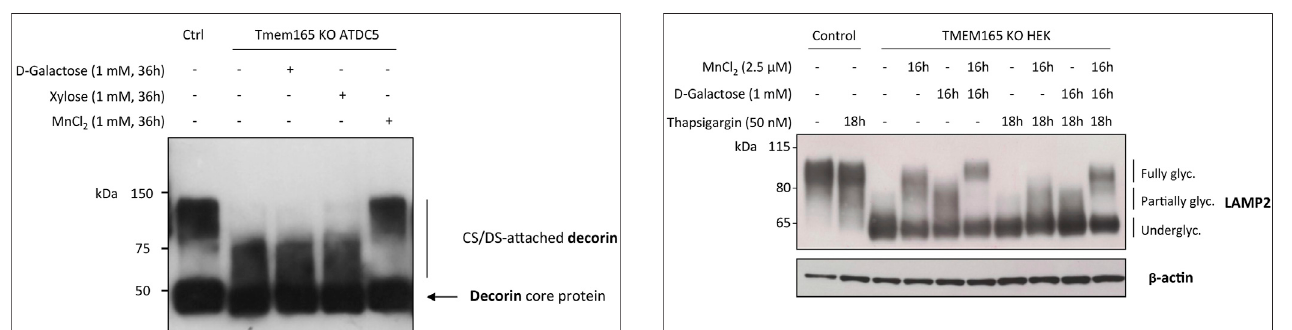
FIGURE 6 | Impact of thapsigargin on LAMP2 and TGN46 glycosylation pro fi les in HEK cells treated with MnCl 2 and/or D-Galactose. Western-blot of LAMP2 incontroland TMEM165KOHEKcells, treatedfortheindicatedtimes with or without 2.5 μ M MnCl 2 and/or 1 mM D-Gal, in the presence or absence of 50 nM thapsigargin, a SERCA pump inhibitor. The electrophoretic migration positions of the fully- and under-glycosylated forms of proteins are indicated on the right side of the western blot ( n =